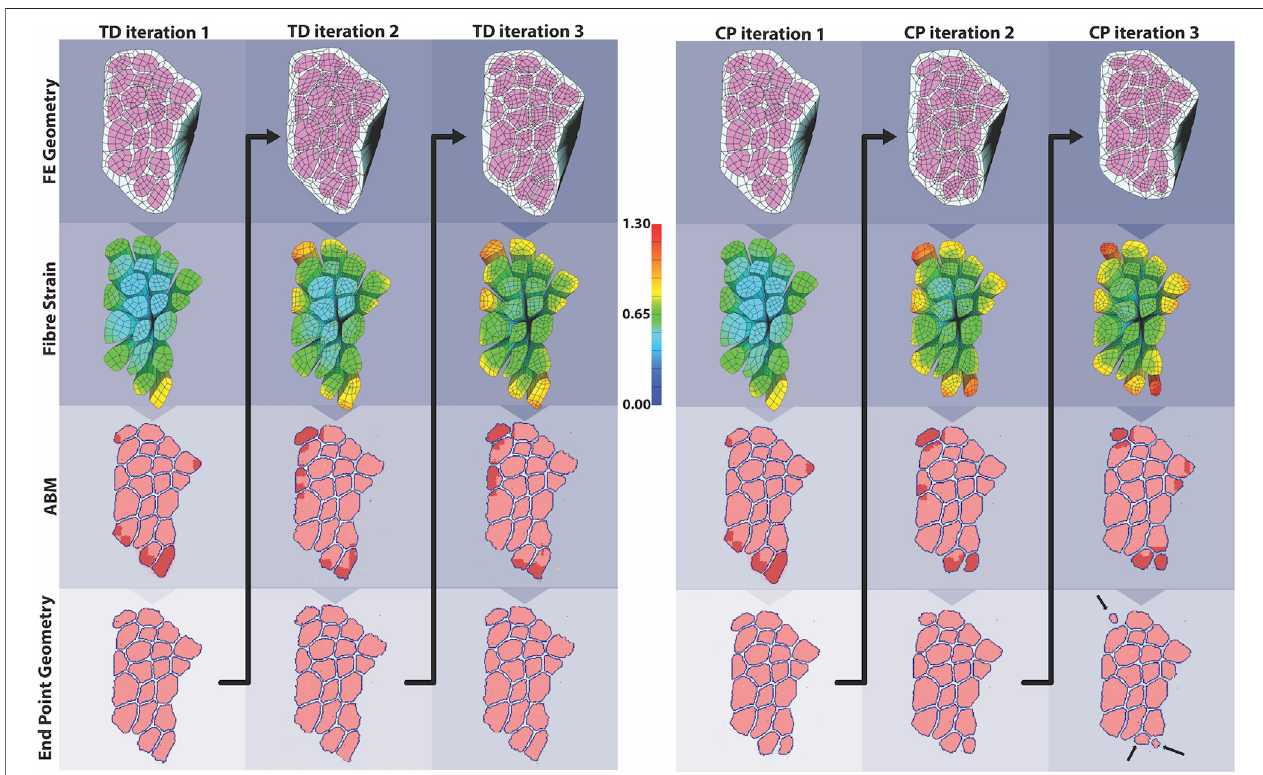
FIGURE 9 | In the coupled ABM-FE modeling mechanobiological simulations, the initial geometry leads to two unique endpoint geometries, according to whether the agent-based models had a cellular milieu based on CP or TD muscle. Each of those endpoint geometries then leads to a new FE model geometry and simulation, where high strains differ based on the geometry from the previous step. Ultimately, divergent geometries emerge, re fl ecting the different CP vs TD muscle outcomes, where TD muscle regenerates fully each cycle and CP muscle fi bers cyclically degenerate.